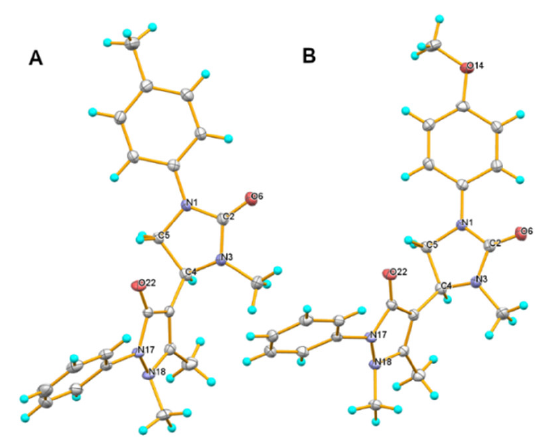
Figure 2. Molecular structure of the compounds 2j ( A ) and 2k ( B ). Ellipsoids are given with a 50% probability.